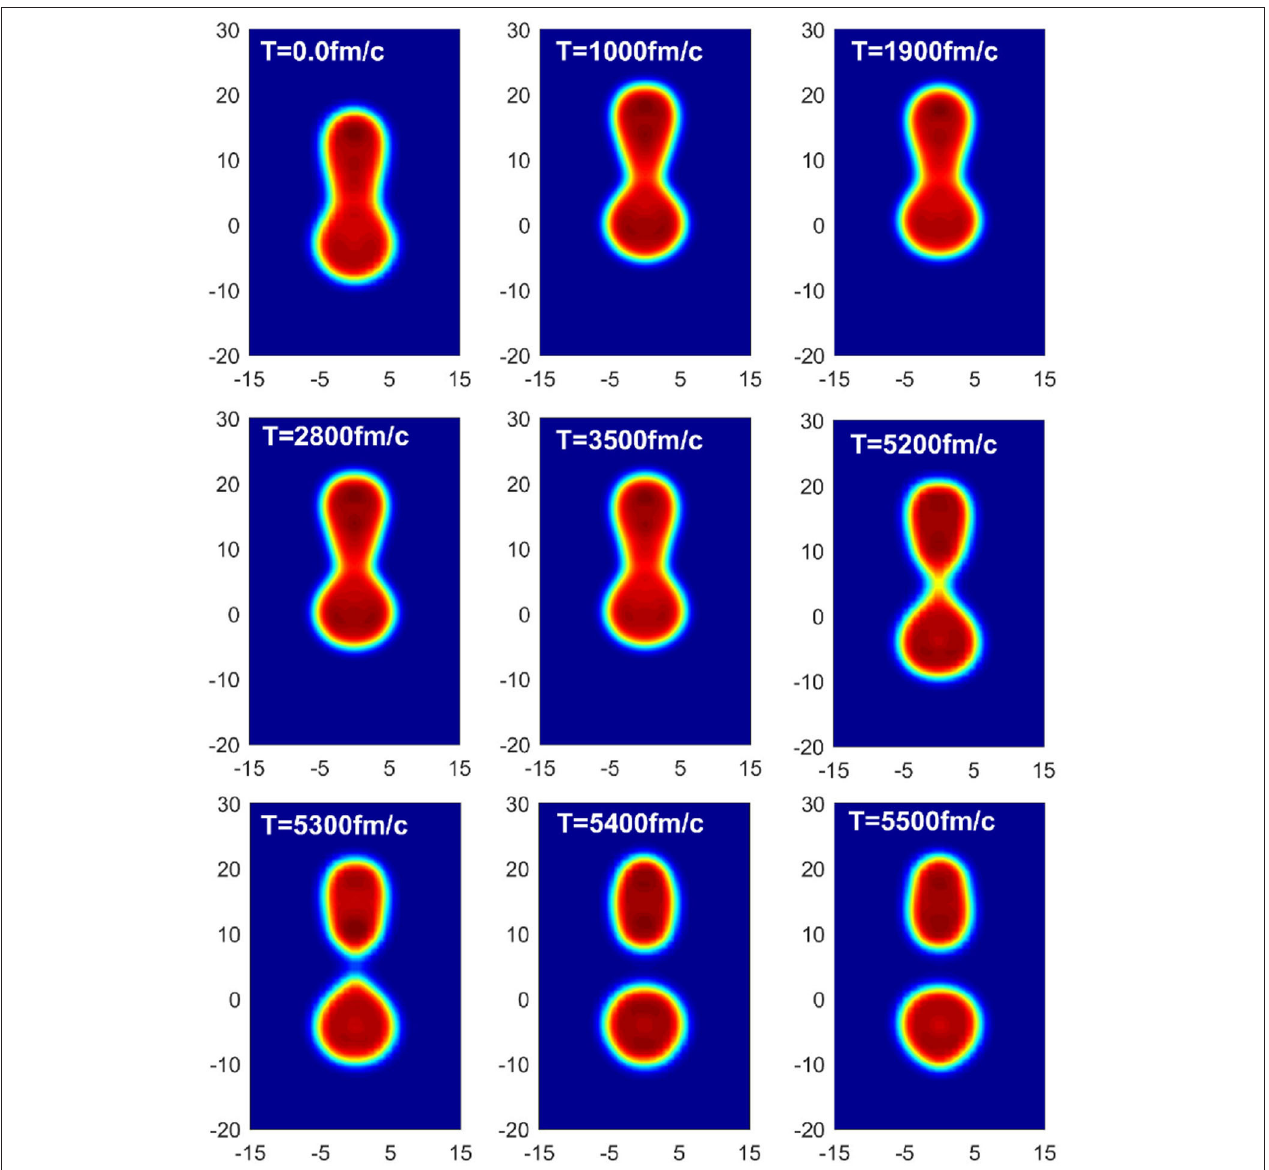
FIGURE 6 | The density evolutions of the 240 Pu fission in TDHF calculations with the SV-sym34